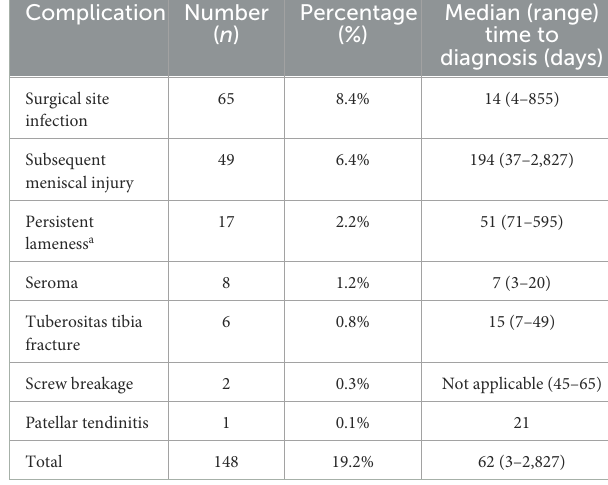
(Table 5). After one TPLO, two different MDR bacteria ( S . aureus and A. baumanii ) were isolated from the same surgical